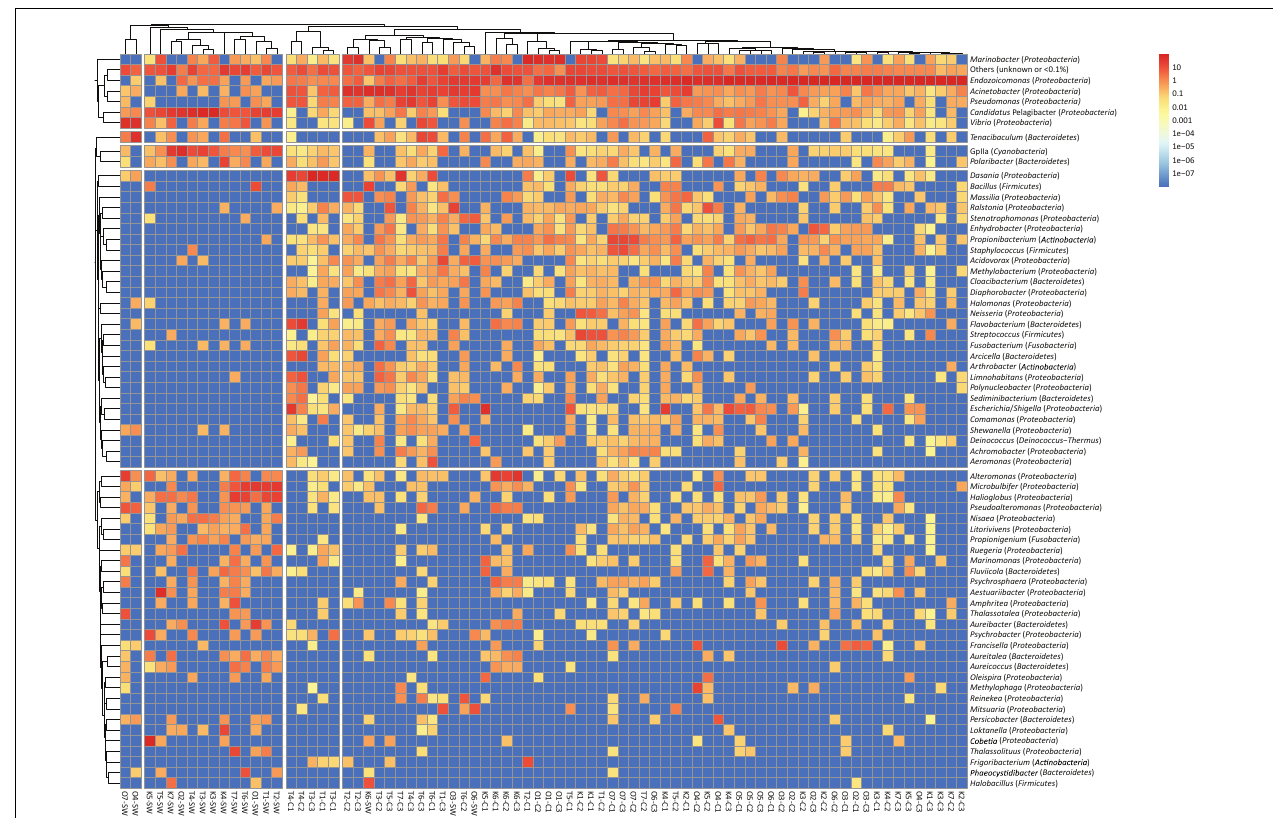
FIGURE 1 | Clustering analysis of bacterial genera in Acropora muricata and seawater from Kochi, Okinawa, and Taiwan. A total of 68 genera remained in the analysis after excluding genera of unknown taxonomy or < 0.1% relative abundance. Trees were cut at four and five groups in columns and rows, respectively. The color scale indicates the relative abundance (percentage). Columns are clustered by Bray–Curtis distance and rows by Euclidean distance of their abundance